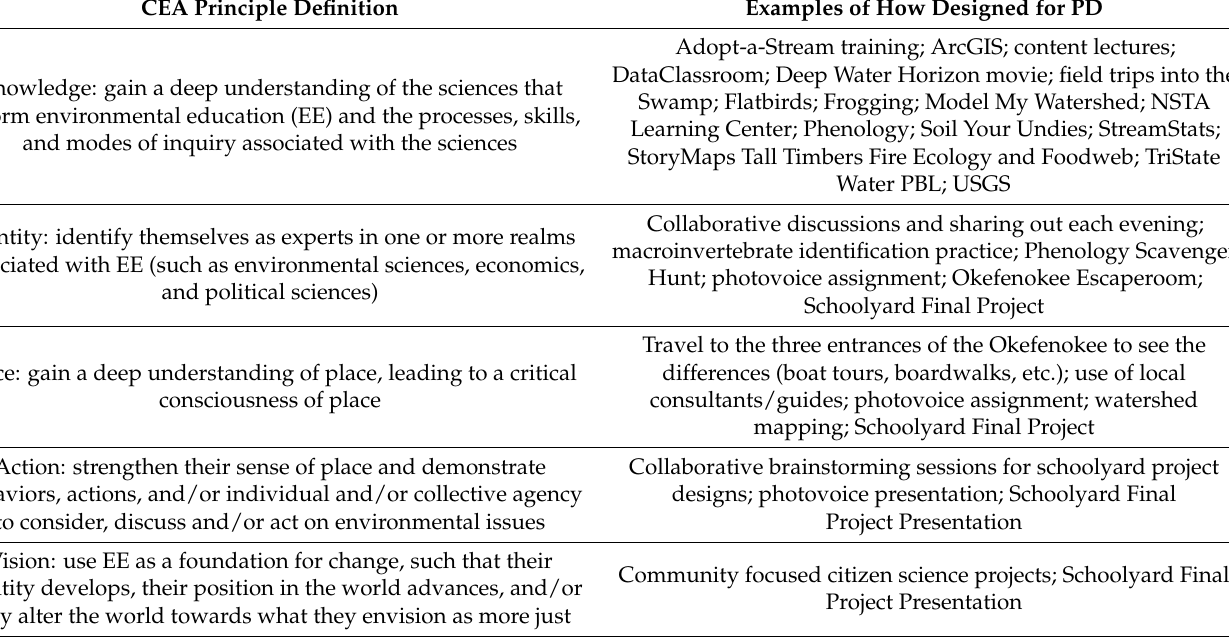
Table 1. CEA principles and examples of how PD was